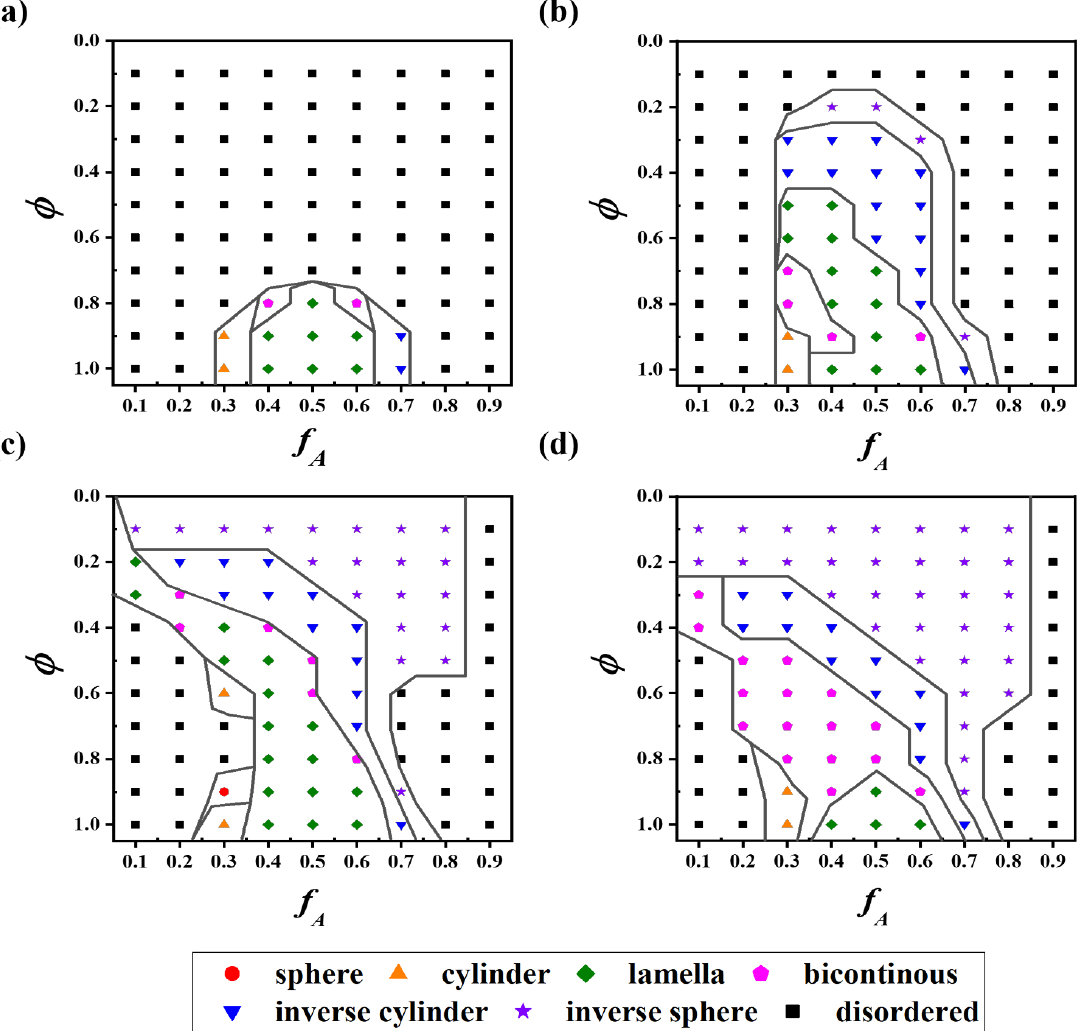
Figure 3. Phase diagrams of block copolymer (BCP) solutions obtained from Grid-less Monte Carlo (MC-G) simulations. Two-dimensional phase diagrams of diblock copolymers in solution as a function of f A and φ for four different systems are presented. While solvent quality is fixed as good for A block ( v aa,dilute = 2.0, w aaa,dilute = 0.0) for all cases, the solvent quality for B block varies: ( a ) good ( v bb,dilute = v aa,dilute , w bbb,dilute = w aaa,dilute ); ( b ) Θ -solvent ( v bb,dilute = − 0.1656, w bbb,dilute = 0.00564); ( c ) marginally poor ( v bb,dilute = − 4.0, w bbb,dilute = 0.04); ( d ) poor ( v bb,dilute = v melt , w bbb,dilute = w melt ). Red circles, orange triangles, green diamonds, pink pentagons, blue inverse triangles, purple triangles, and black squares represent sphere, cylinder, lamella, bicontinuous, inverse cylinder, inverse sphere, and disordered phase, respectively. Rough phase boundaries in the black line are also drawn in all